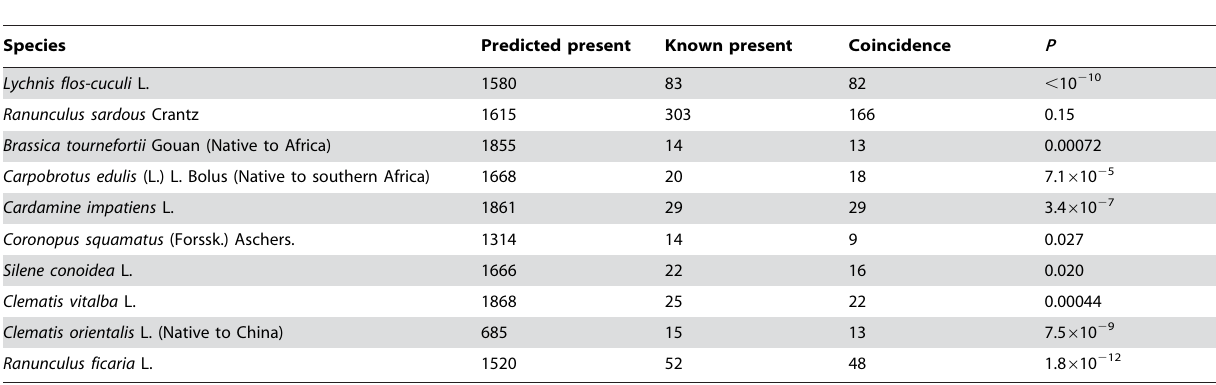
Table 1. Summary of results of tests of intercontinental predictive ability for 10 exemplar species.